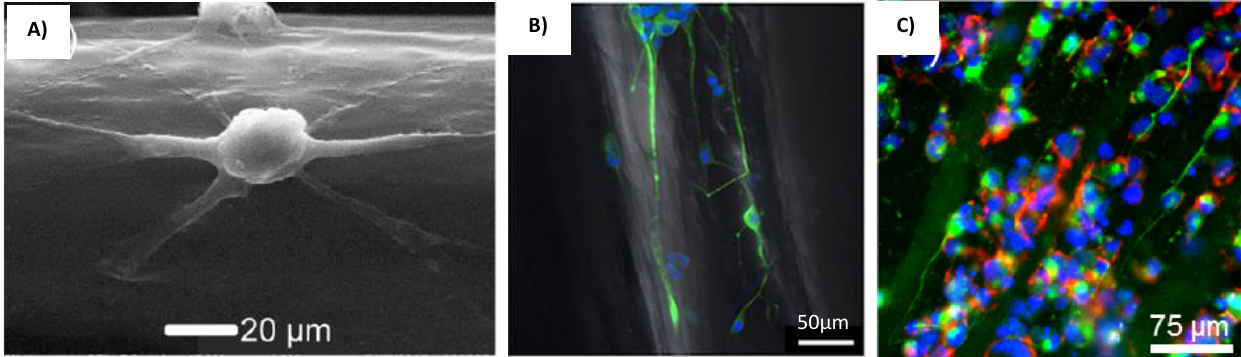
Figure 6. Cells cultured on different microfluidic scaffolds. ( A ) SEM images of the AHPCs cultured on the PCL microfibers [73]. Reprinted with permission copyright © 2016 American Chemical Society. ( B ) PC-12 cells cultured on the bundle gel fibers [74]. Reprinted with permission copyright © American Chemical Society. ( C ) Neuronal NG108-15 cells on microfluidics-produced collagen microfibers [75]. Reprinted with permission copyright © 2016 American Chemical Society.